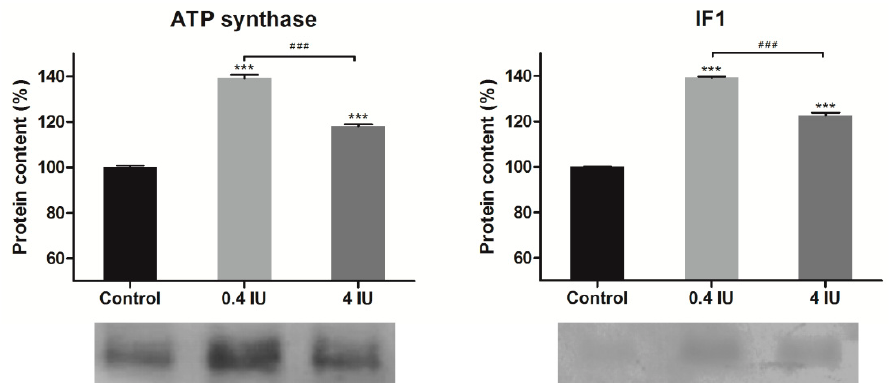
Figure 5. E ff ects of acute insulin treatment on the expression of ATP synthase and inhibitory factor 1 (IF1) in MEF. Protein content is expressed relative to controls, which were standardized to 100%. Mean ± SEM values are averages of three independent experiments performed in triplicate (pooled from six animals in each group). A representative blot is shown. Volume is the sum of all pixel intensities within a band (1 pixel = 0.007744 mm 2 ). * compared to control: *** p ≤ 0.001; # 0.4 IU vs. 4 IU: ### p ≤ 0.001.